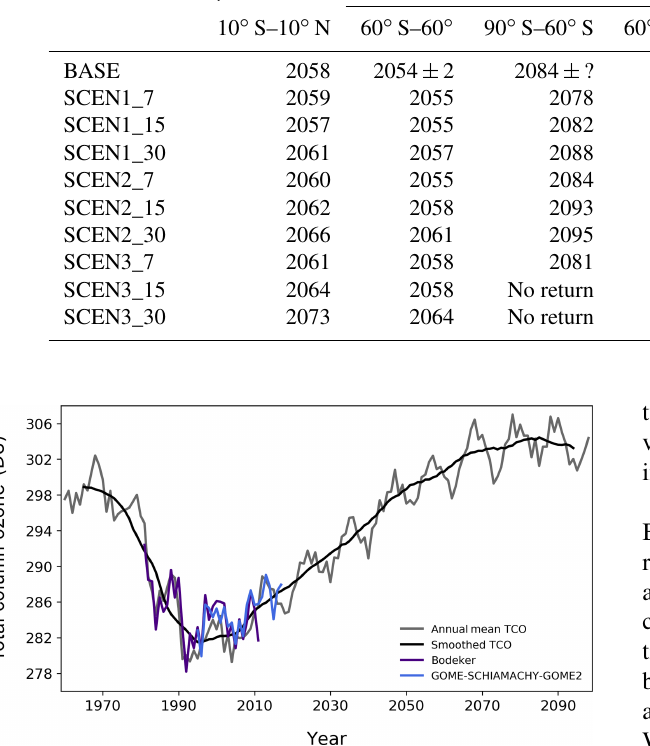
Table 1. Cl y return date (defined as the date at which Cl y mixing ratios, averaged from 10 ◦ S–10 ◦ N at 40km, return to the BASE simulation 1980 value) and the date TCO returns to the 1960–1980 mean in the BASE and SCEN simulations. Uncertainty estimates for the TCO return date in the BASE simulation are provided by a separate five-member ensemble, as described in the text. TCO return to the 1960–1980 mean occurs after 2080 for the latitude range 90–60 ◦ S, and so no uncertainty estimate can be provided for this latitude band, denoted by “ ± ?” in the table. Date of total column ozone (TCO) return to 1960–1980 mean.